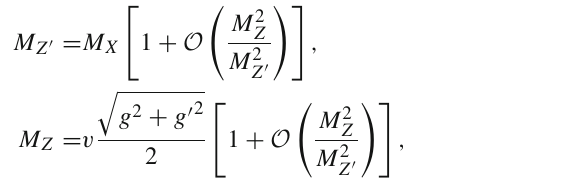
Fig. 1 A Z (cid:2) -boson mediated contribution to b → s μ + μ − transitions Fig. 2 A Z (cid:2) -boson mediated contribution to B s − B s mixing